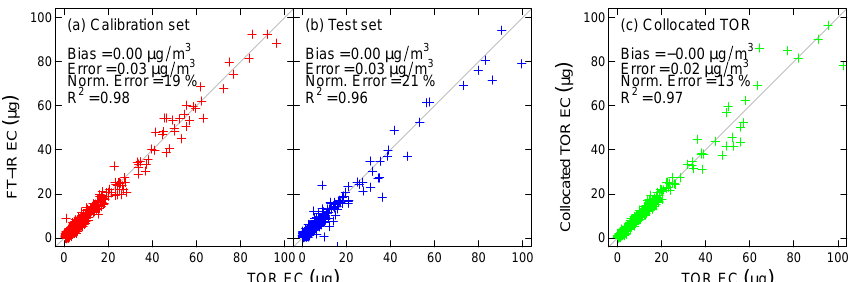
Figure 3. Predicted EC for calibration set (a) and test set (b) for the Base case using a hybrid calibration model. The collocated TOR samples (c) are from sites with parallel quartz filters that are both analyzed by TOR. Only the Phoenix site has samples in the calibration, test and collocated data sets. There are 521 samples in the calibration set (a) , 265 samples in the test set (b) and 431 samples in the collocated TOR data set (c) . Concentration units of µgm − 3 for bias and error are based on the IMPROVE nominal volume of 32.8m 3 .